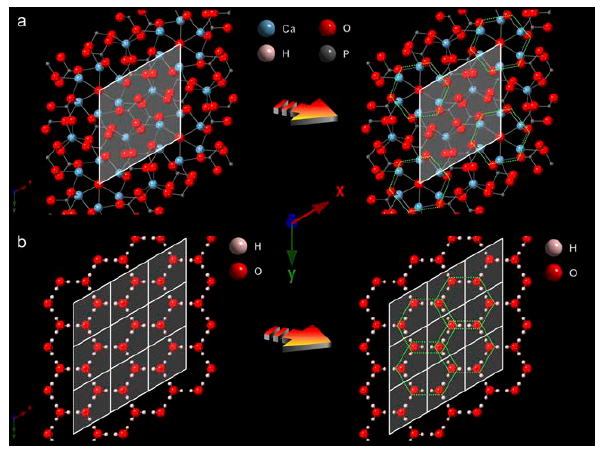
Figure 4. Crystal structures of hydroxyapatite (a) and water (b) when viewed down the c-axis. Shaded parallelograms denote the unit cells, while the four nearest hexagons to the unit cell are marked with dashed green lines for each